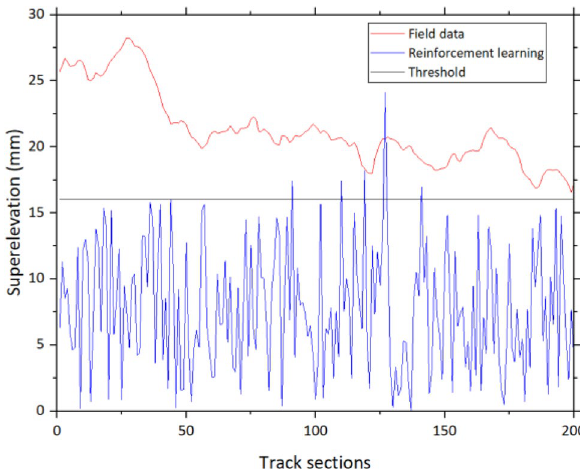
Figure 12. Examples of